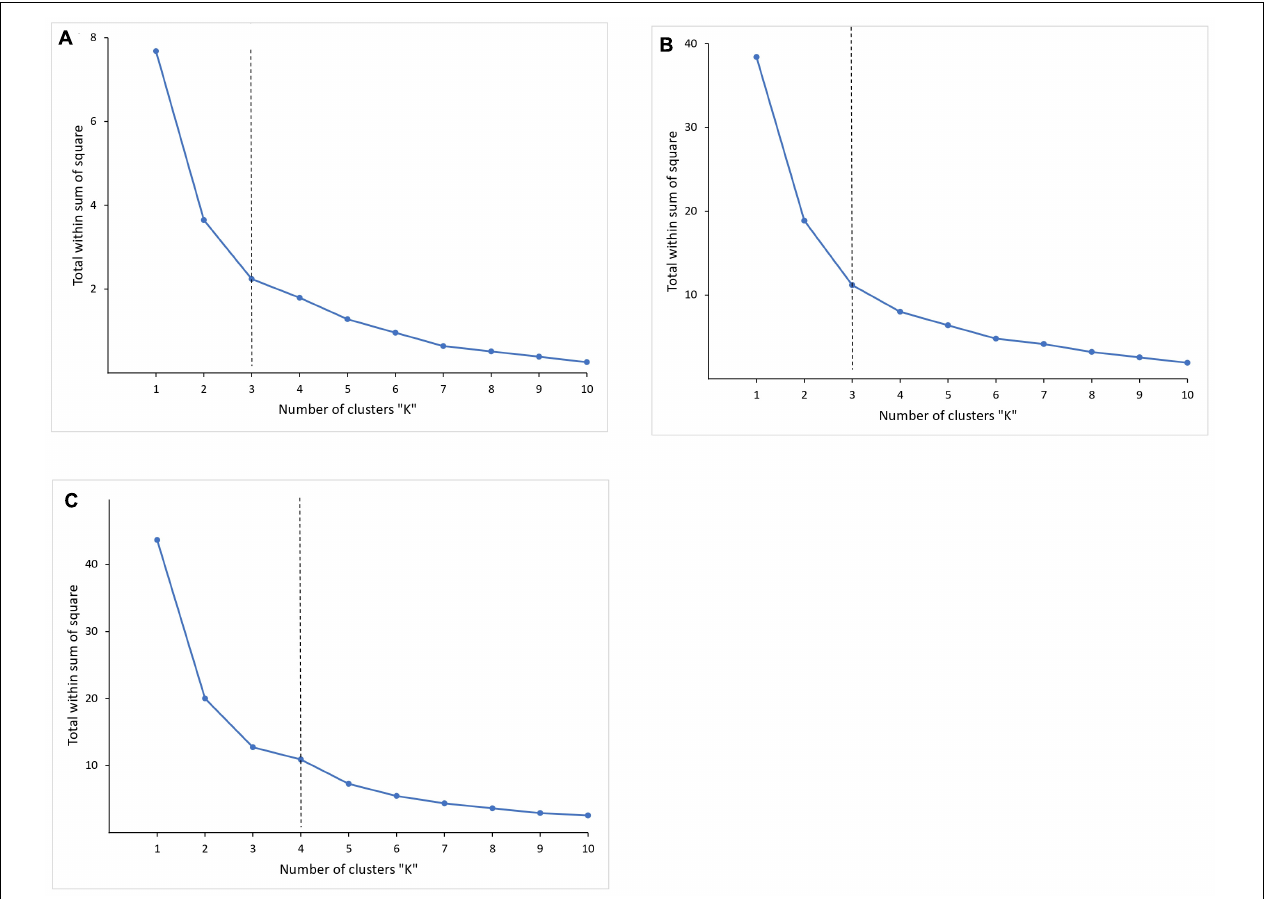
FIGURE 4 | The graph is showing the dissimilarity within the clusters by calculating the within clusters sum of squares for corresponding number of clusters. The curves are not showing an obvious point where the curve starts to flatten out. However, it can be observed from the curves that it is decreasing at k = 3, k = 3 and k = 4, which can be considered as optimal-K for respective HEC1 (A) , HEC2 (B) , and HEC3 (C)